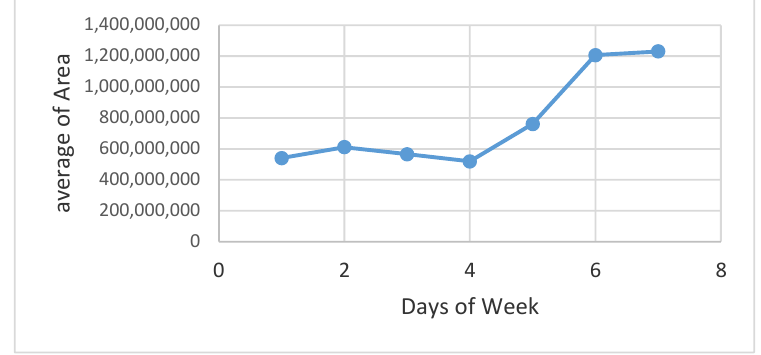
Table 2. Average and standard deviation of area and shape index of users' activity space grouped by weekdays and weekends